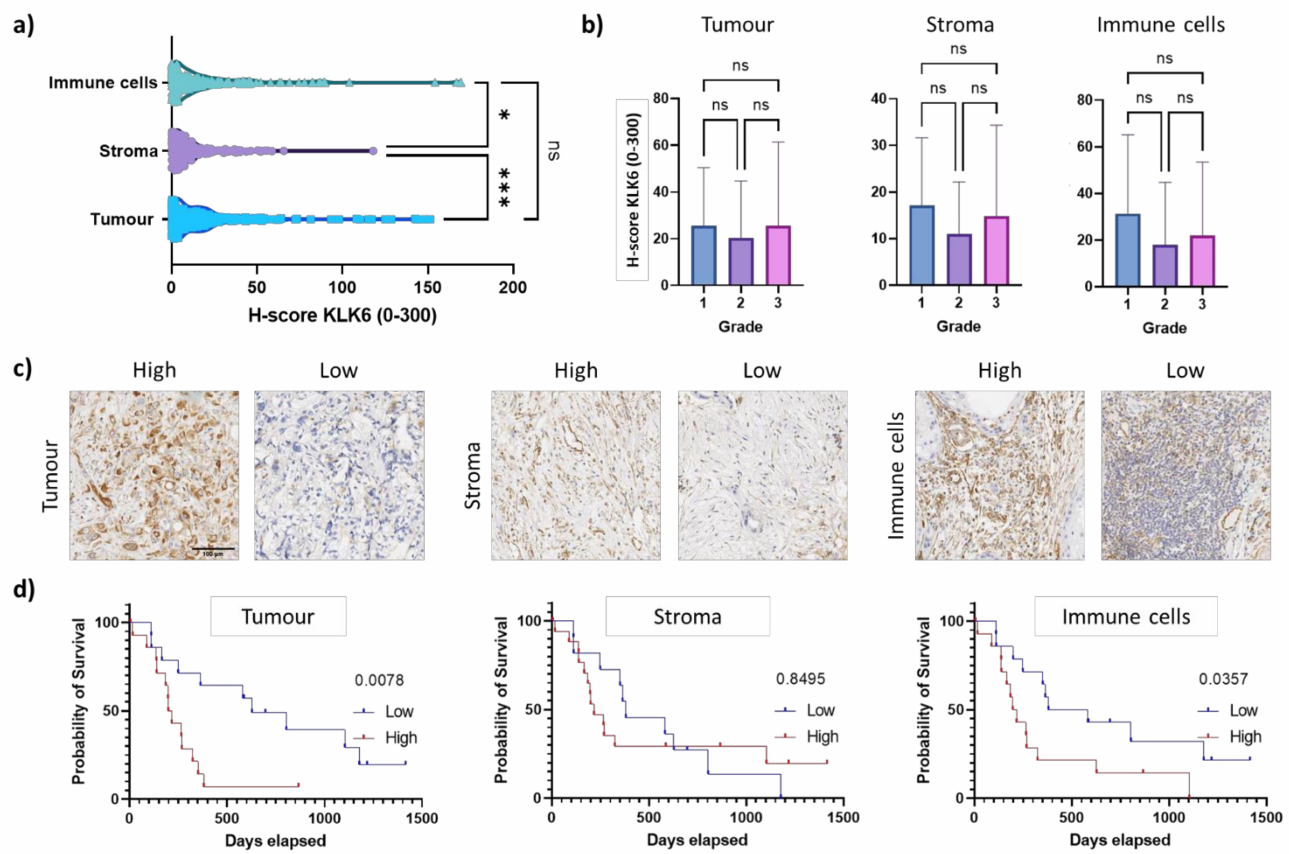
Figure 4. KLK6 protein expression in PDAC tissues. ( a ) KLK6 protein levels were significantly higher in the tumour and immune cells compared to the stroma. ( b ) KLK6 expression in tumour, stroma and immune cells did not correlate with tumour grade. ( c ) Representative images of the high and low KLK6 staining intensity in the tumour, stroma and immune cell areas. ( d ) Kaplan–Meier analysis indicated that high KLK6 expression levels in the tumour ( p = 0.0078) and immune cells ( p = 0.0357) were significantly associated with shorter survival than low expression levels (individuals from 2005 onwards). Scale bar, 100 µ m. Asterisks indicate statistical significance (* p ≤ 0.05 and *** p ≤ 0.001; ns, not